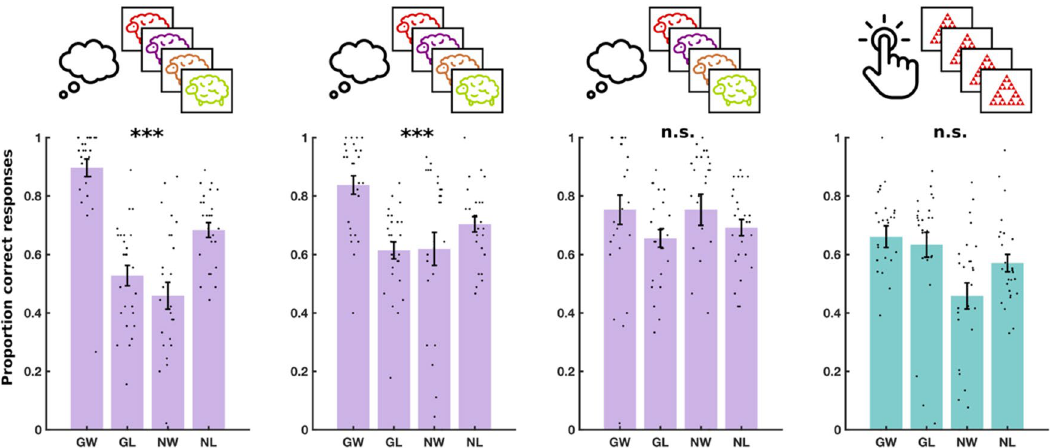
Figure 3. Experiment 2 results. Performance in three daily training sessions of SS g+ and a fourth testing session of MM on day 3. Each dot shows the average performance for an individual subject in one of the four conditions: Go to win (GW), go to avoid losing (GA), no-go to win (NW) and no-go to avoid losing (NL). Error bars show standard error of the mean across participants. Significance stars show P-value ranges for the interaction between valence (win/avoid losing) and choice (go/no-go) on performance. ***P < 0.001. n.s. P >